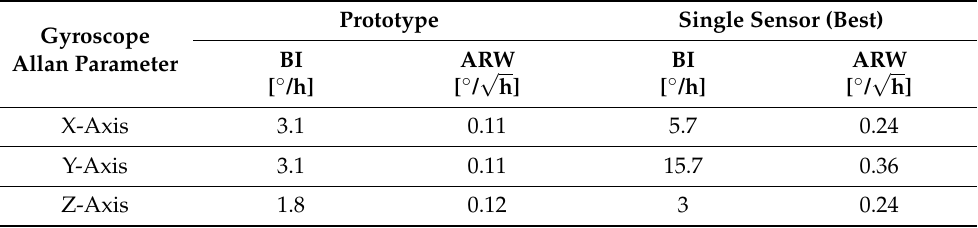
Table 2. Gyro parameters estimated through Allan variance.